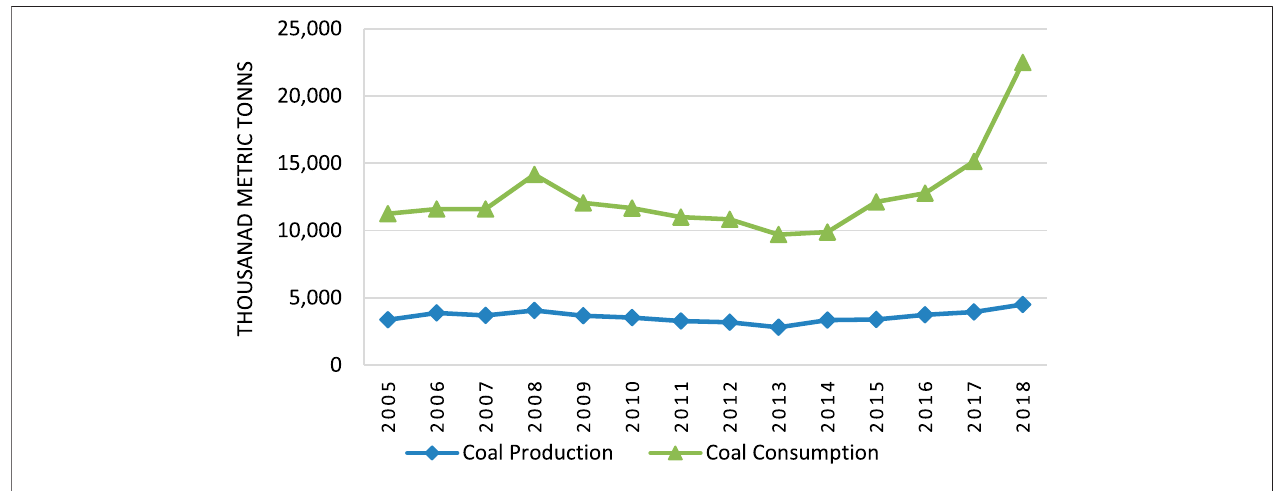
FIGURE 3 | Pakis tan ’ s co al production and consumption 3